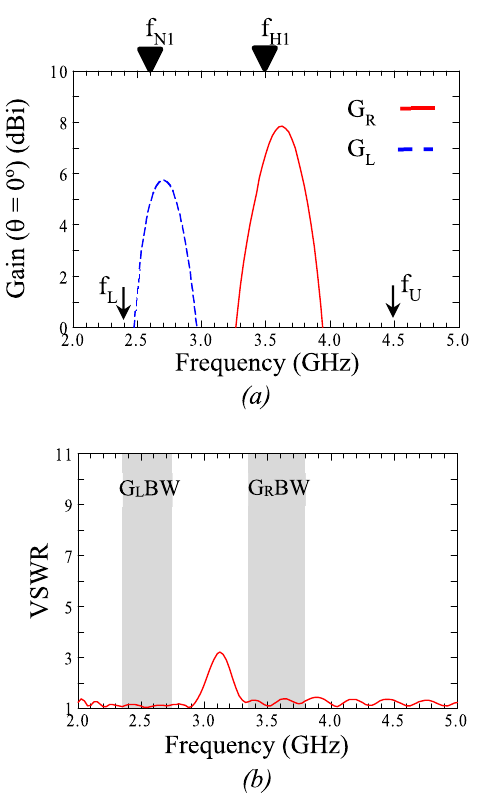
Fig. 10. Frequency response for the round metaloop-C antenna (RND-MTLP-C). (a) LHCP and RHCP gains. (b) VSWR.